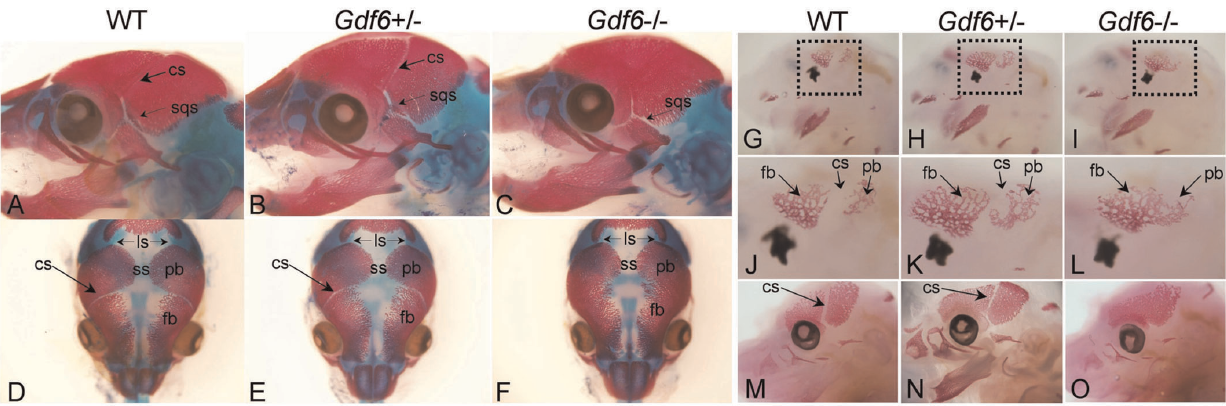
Figure 1. Analysis of coronal suture development in wild-type and Gdf6 2 / 2 embryos with alizarin red. The coronal suture separated the frontal and parietal bones in wild-type and heterozygote embryos (A, B), but was lacking in the Gdf6 2 / 2 embryos (C). At E14.5, the early coronal suture was a distinct gap between the frontal and parietal ossification centers (G, H, J, K). The coronal suture appeared fused in Gdf6 2 / 2 embryos at the onset of ossification (I, L). The frontal and parietal bones fused into one continuous bone in the Gdf6 2 / 2 at E15.5 (O). The sagittal, lambdoid (D– F), and squamosal (A–C) sutures remained unfused through weaning in both wild-type and Gdf6 2 / 2 animals. fb, frontal bone; pb, parietal bone, cs, coronal suture; ls, lambdoid suture; sqs, squamosal suture.